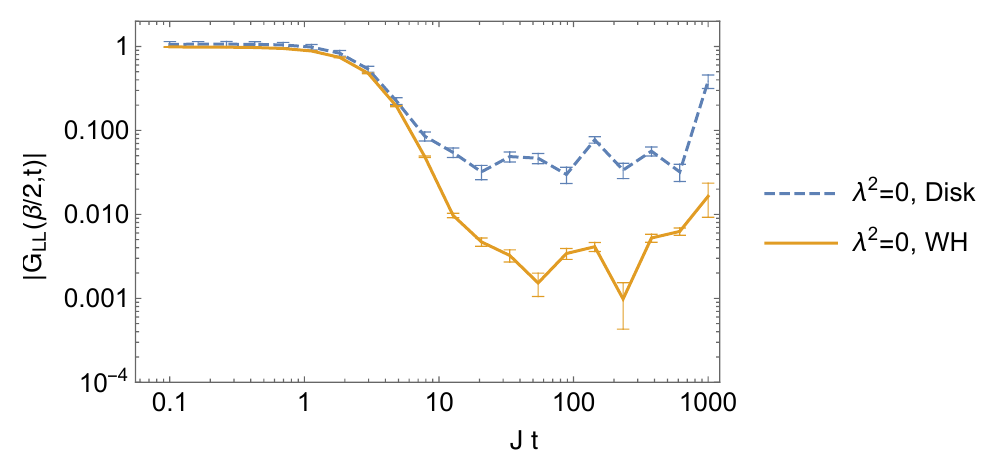
Figure 4 . The 2-pt correlator | G LL | as a function of Lorentzian time for the λ 2 = 0 disk and wormhole for the case of many marginal couplings. We take N = 20 , n trials = 600 , β J = 1 , JT = 10 3 . Notice that as t → T we reach the second quench site. For the disk solution, a prediction from the large q analysis is that the correlator becomes large on the disk, whereas it remains small on the wormhole. This seems to be in rough agreement with the modest N, q = 4 numerics. In